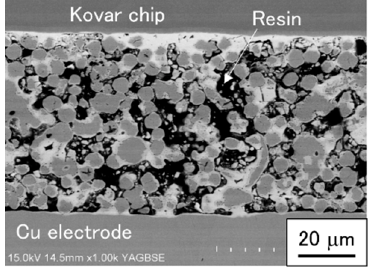
Figure 5. Cross-sectional SEM image of an as-bonded TLPS joint.